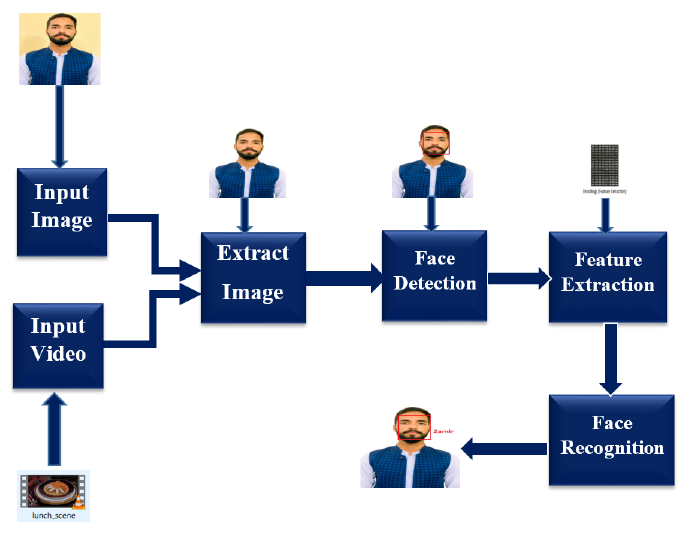
Figure 1. Generic framework for face